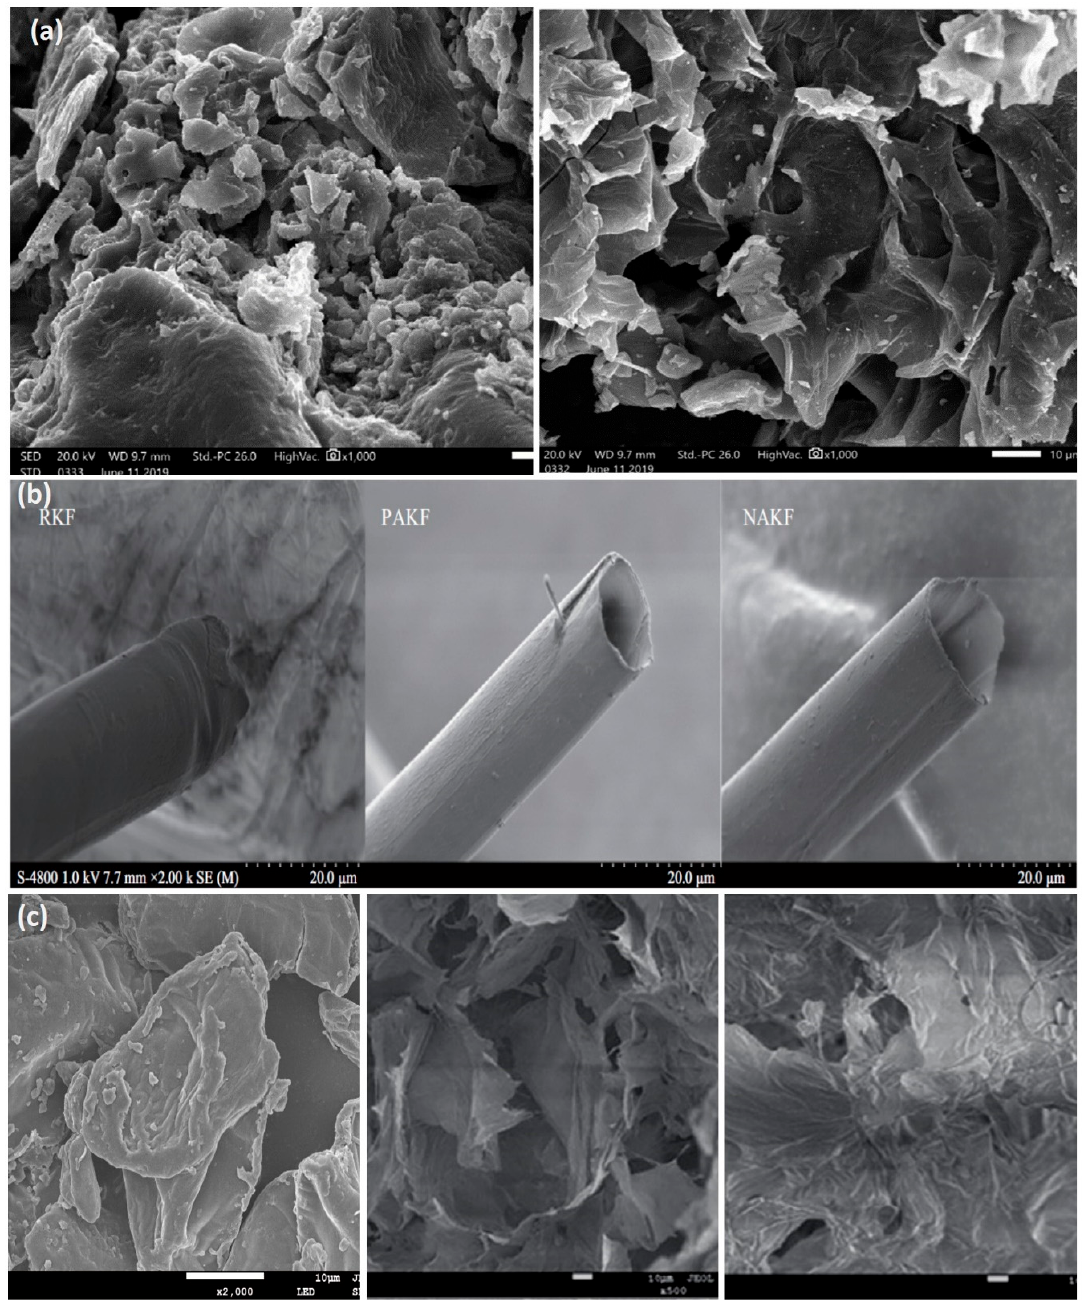
Figure 5. SEM images of ( a ) raw orange peel (OP) and orange peel thermally modified (TMOP) at 500 ◦ C (adapted from [34] with permission from Elsevier), ( b ) of raw kapok fiber (RKF), pyridine-catalyzed kapok fiber (PAKF), and NBS-catalyzed kapok fiber (NAKF) (adapted from [82] with permission from Elsevier), ( c ) raw pomelo peel, pomelo sponge aerogels (PSA), and hydrophobic sponge aerogels (HPSA) with MTMS (adapted from [86] with permission from RS).